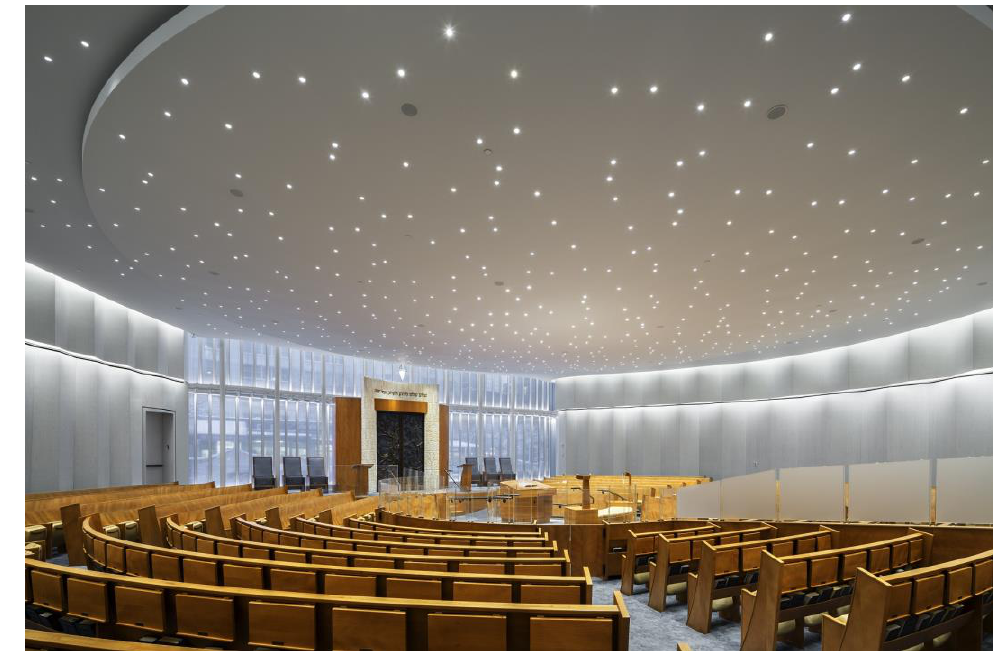
Figure 8. Sanctuary interior. Photo David Sundberg/ESTO.